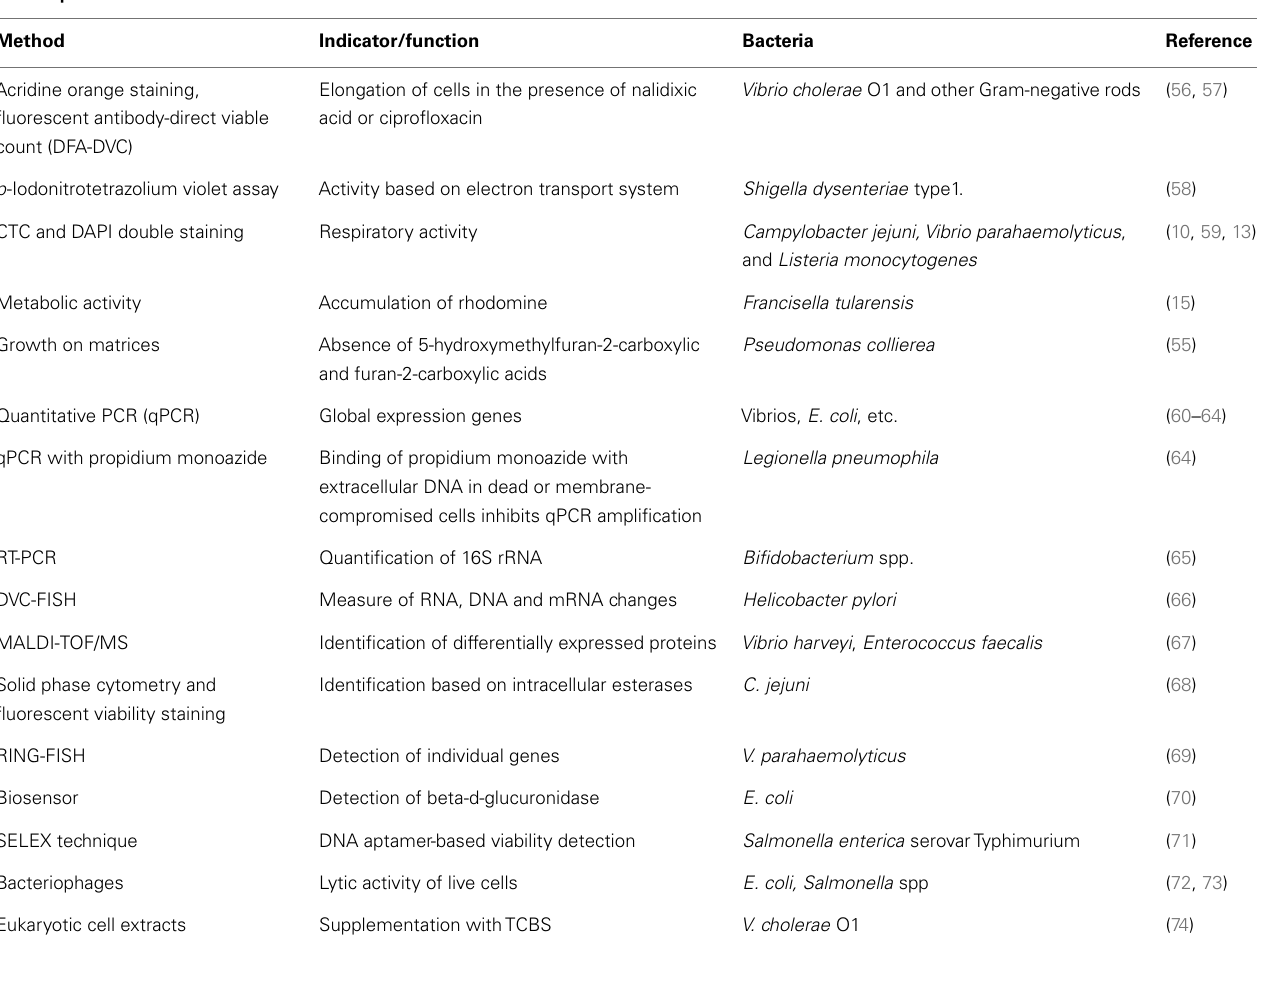
Table 1 | Methods for the detection ofVBNC bacteria